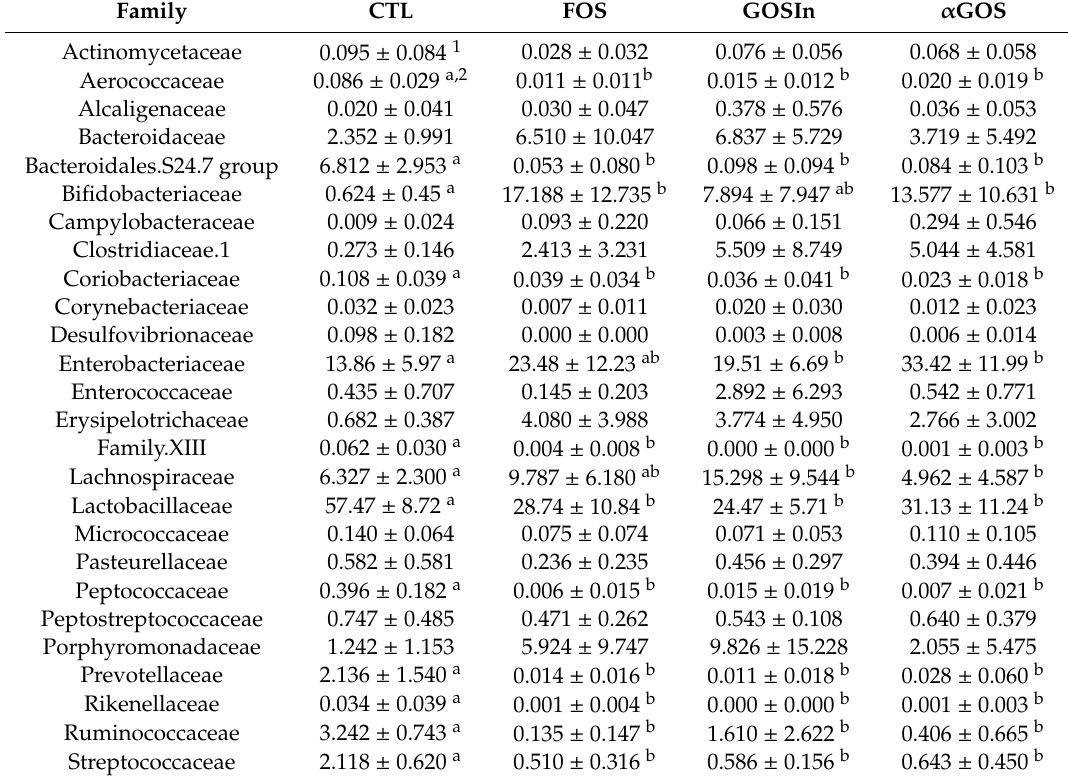
Table 3. Relative abundances (%) for families with abundances > 0.01% at PND14 / 15 according to the postnatal OS supplementation.